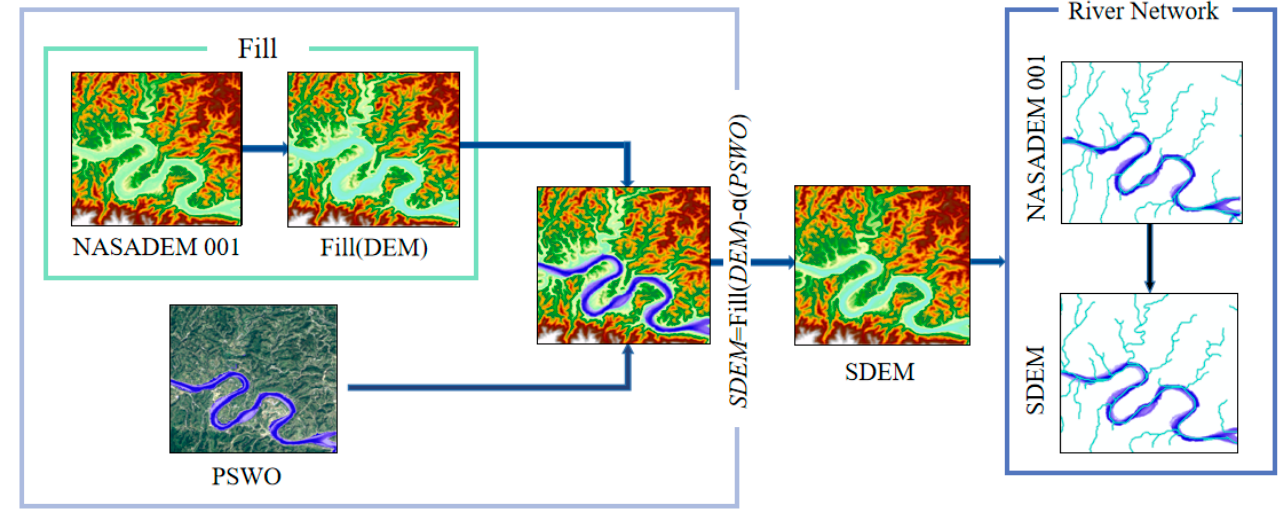
Figure 3. Flow chart of the stream burning of originality DEM based on PSWO.